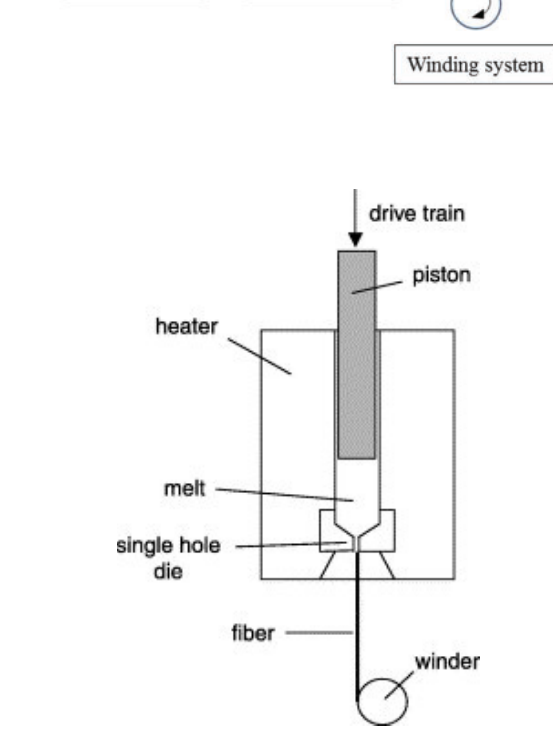
Figure 1: Wet-spinning device [3]